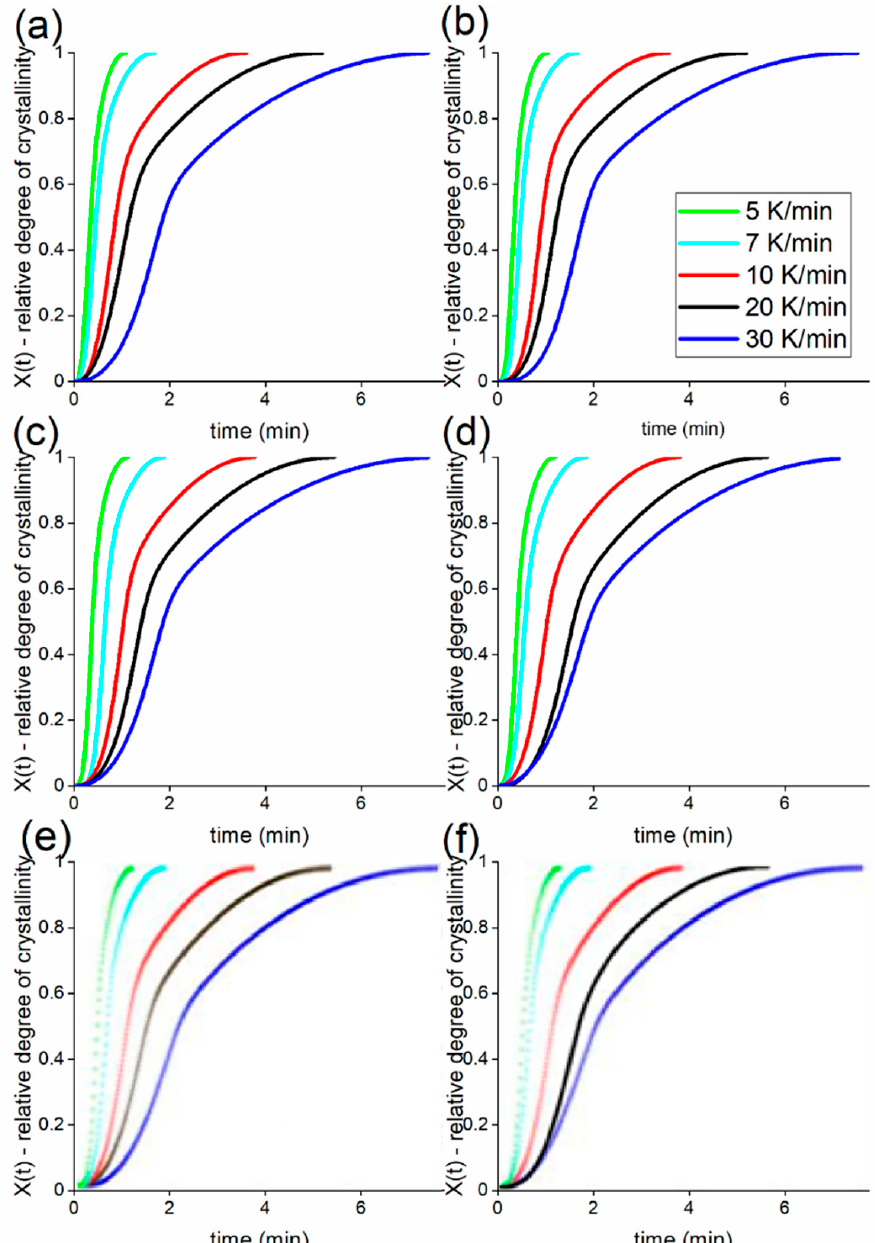
Figure 9. Relative crystallinity as a function of time for pure EVA20 ( a ) and its GNP-based composites with loadings of 0.2 vol% ( b ), 1.7 vol% ( c ), 3.6 vol% ( d ), 4.5 vol% ( e ) and 6.5 vol% ( f ) at cooling rates between 5 K/min and 30 K/min. Table 5. Apparent half times t 1/2 of the EVA20/CB composites’ crystallisation process at different cooling rates. The pure EVA20 noted as 0 vol% is displayed for comparison.